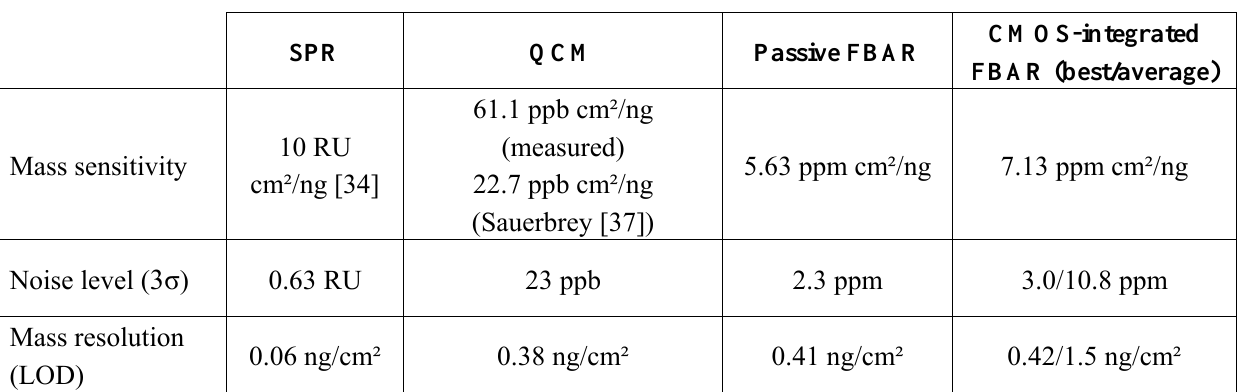
Table 1. Mass sensitivity, frequency noise and limit of detection for SPR, QCM, the passive and the CMOS-integrated FBAR. The mass sensitivity for the acoustic resonators is relative to their resonance frequency. For the CMOS- integrated FBAR, the noise and LOD from the best pixel and the average over a 64-pixel array are